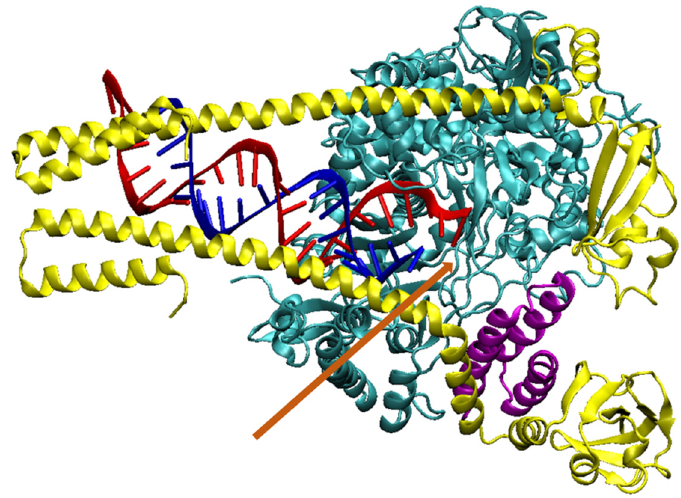
Figure 2. Structure of the SARS-CoV-2 replication complex. nsp12 (cyan), nsp7 (magenta), nsp8a, b (yellow), product strand (blue), and template strand (red). The VMD software is used to obtain this image. The orange arrow indicates the active site.